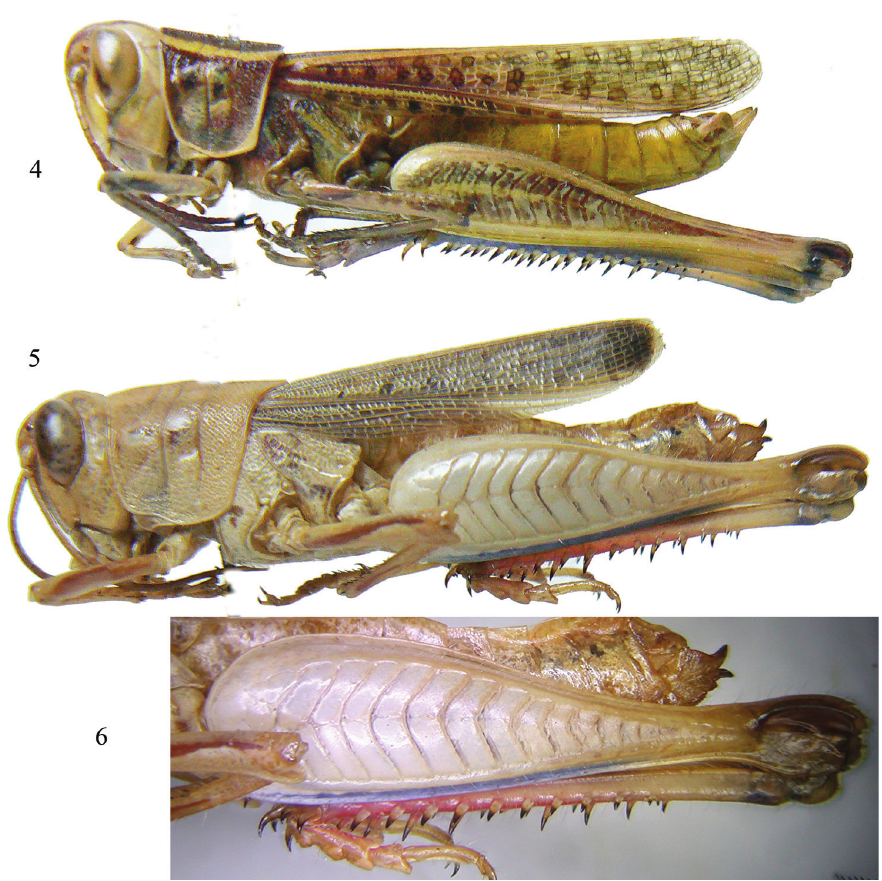
ssp.: habitus of female 6 detail of the hind femur of the same.